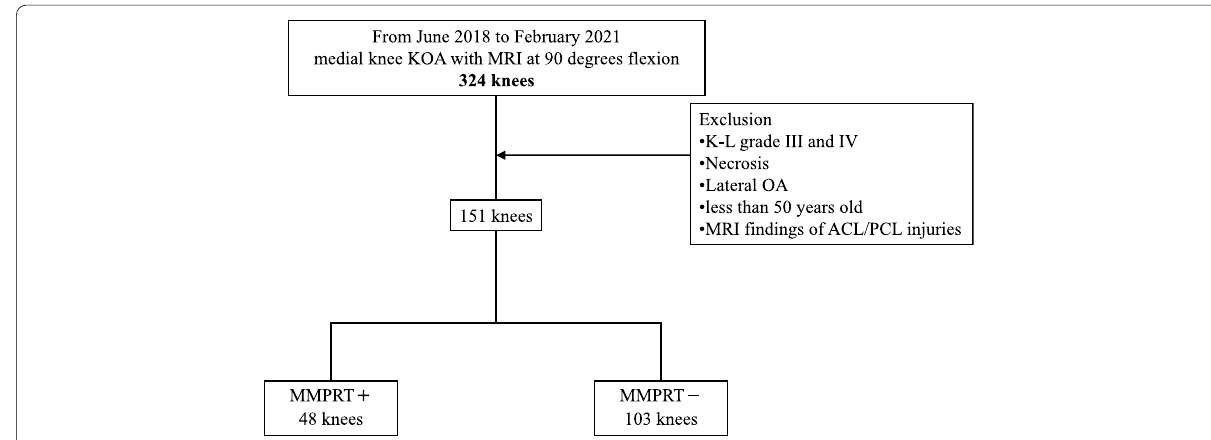
Fig. 1 Flow chart of material selection of this study with inclusion and exclusion criteria